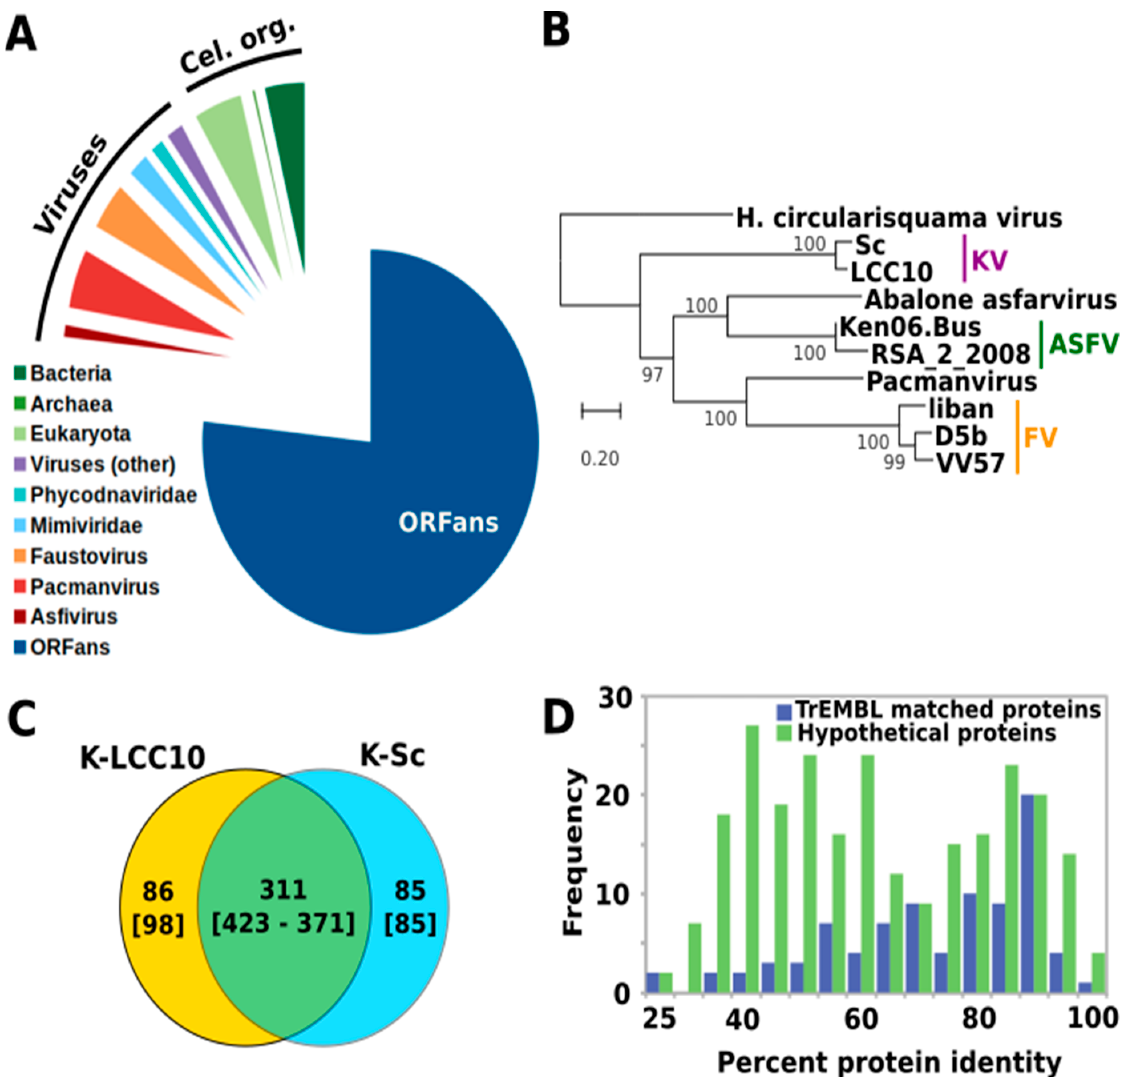
Figure 3. Comparative genomics of KV-LCC10. ( A ) Taxonomic classification of the KV-LCC10 protein best matches in the TrEMBL database. Best matches were identified with MMSEQS and a E-value threshold of 1E-05. Match to KV-Sc proteins were not included. ( B ) Phylogenetic tree of the DNA polymerase proteins. The multiple alignment was done with MAFFT and the phylogenetic tree was reconstructed with FastTree using default parameters. Branch supports indicated beside internal nodes were obtained using the SH-aLRT method as implemented in FastTree. The scale bar indicates the number of substitutions per amino acid sites. ( C ) Protein families shared between the two KVs strains. Numbers outside and inside brackets indicate the number of protein families involved in the category and the cumulative number of proteins in those families, respectively. For families shared between K-LCC10 and K-Sc, 423 is the number of proteins for K-LCC10 and 371 is the number of proteins for K-Sc. ( D ) Protein sequence similarity between reciprocal best matches between the two KV strains. The blue distribution represents proteins that have a significant match in the TrEMBL database (with exclusion of KV entries); the green distribution represents proteins with no significant matches in TrEMBL and therefore considered as hypothetical proteins.